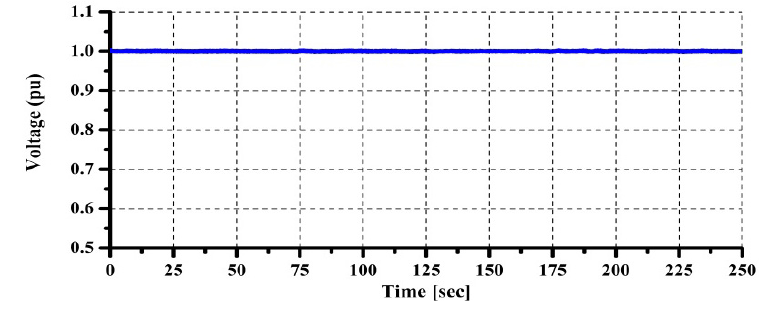
Figure 33. Terminal voltage at